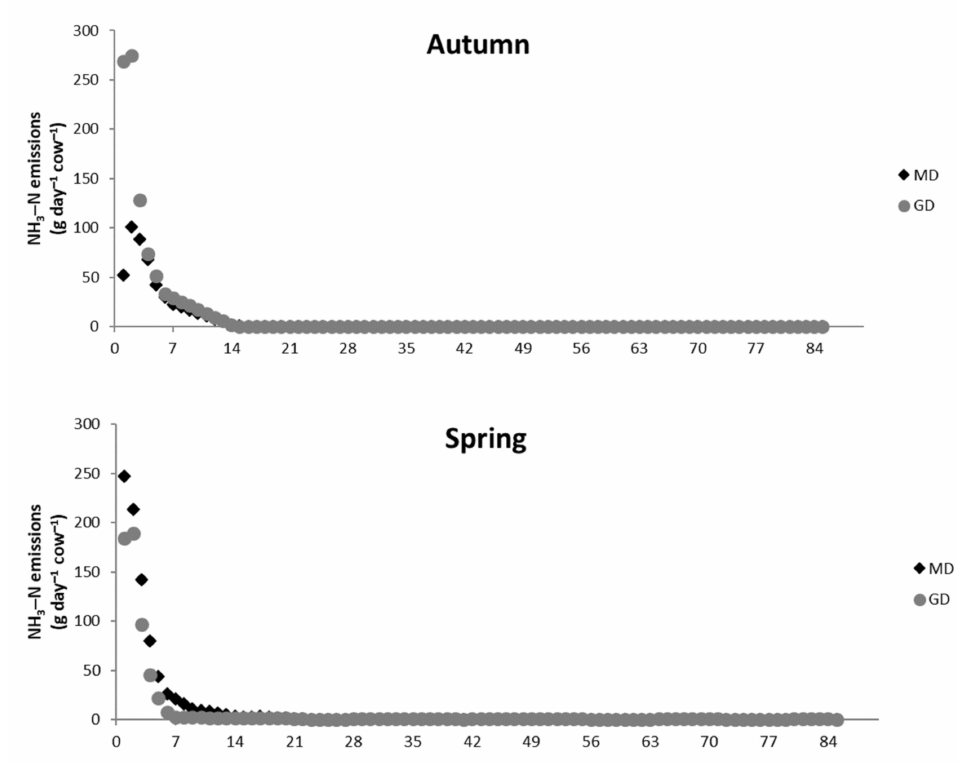
Figure 6. Dynamics of ammonia (NH 3 –N) emissions (g cow –1 day –1 ) over the 85 d of storage in the autumn and spring as a function of diet (a maize-silage-based diet (MD) or a grass-based diet (GD)).